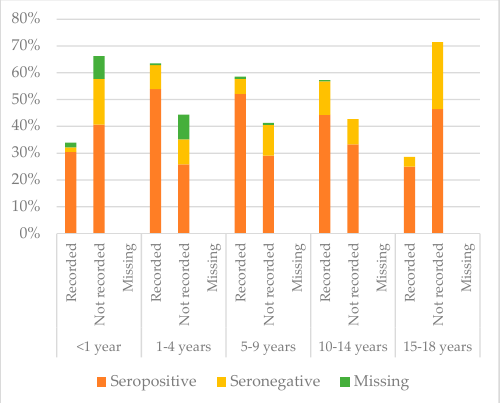
Figure 8. Comparison between immunisation status of IAC reported in the documentation and serology for diphtheria, by age group (Table A5 in the Appendix A).